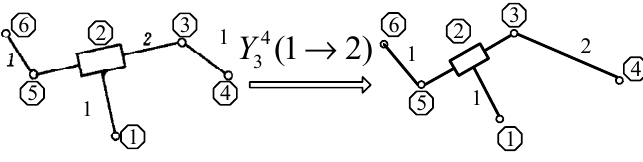
Figure 3. Duplication operation.